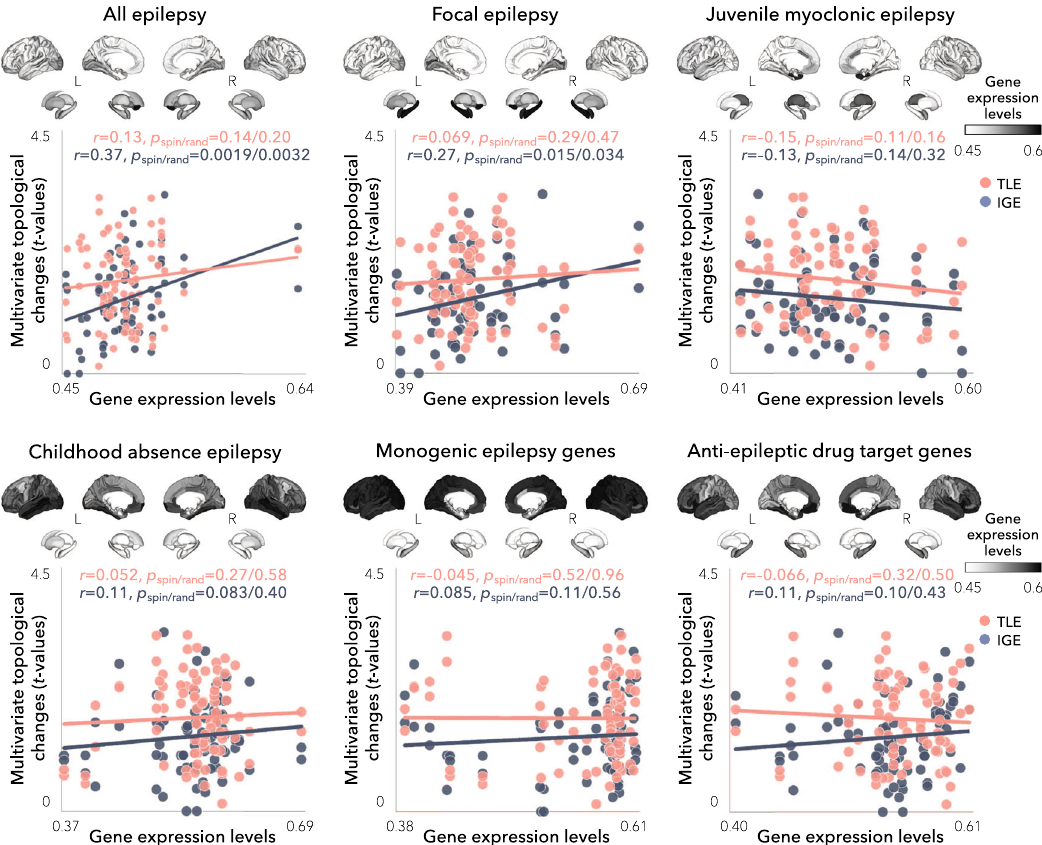
Fig. 4 Relations between epilepsy gene expression and network topology. Gene expression levels associated with (i) all other epilepsy subtypes (all epilepsy, focal epilepsy, juvenile myoclonic epilepsy, and childhood absence epilepsy), (ii) monogenic epilepsy, and (iii) anti-epileptic drug targets were mapped to cortical and subcortical surface templates. Spatial correlations were performed between each of these transcriptomic maps and the patterns of multivariate topological alterations in TLE and IGE across cortical and subcortical regions ( n = 82) and were statistically assessed using one-tailed, non- parametric tests. In IGE, spatial associations between microarray data and multivariate topological changes were signi fi cant for expression levels of all epilepsy genes ( r = 0.37, p spin = 0.0019) and focal epilepsy ( r = 0.27, p spin = 0.015). In TLE, network associations did not correlate with any other epilepsy- related transcriptomic maps. HC = healthy control, IGE = idiopathic generalized epilepsy, TLE = temporal lobe epilepsy, p spin = p -value corrected against a null distribution of effects using a spatial permutation model, p rand = p -value corrected against a null distribution of effects using a “ random-gene ” permutation signi fi cantly weaker when derived from regional atrophy patterns (as opposed to multivariate topological changes) in TLE (correlation with gene expression levels of hippocampal sclerosis: r = 0.041, p spin/rand = 0.50/0.91; Supplementary Fig. 2c) and in IGE (correla-